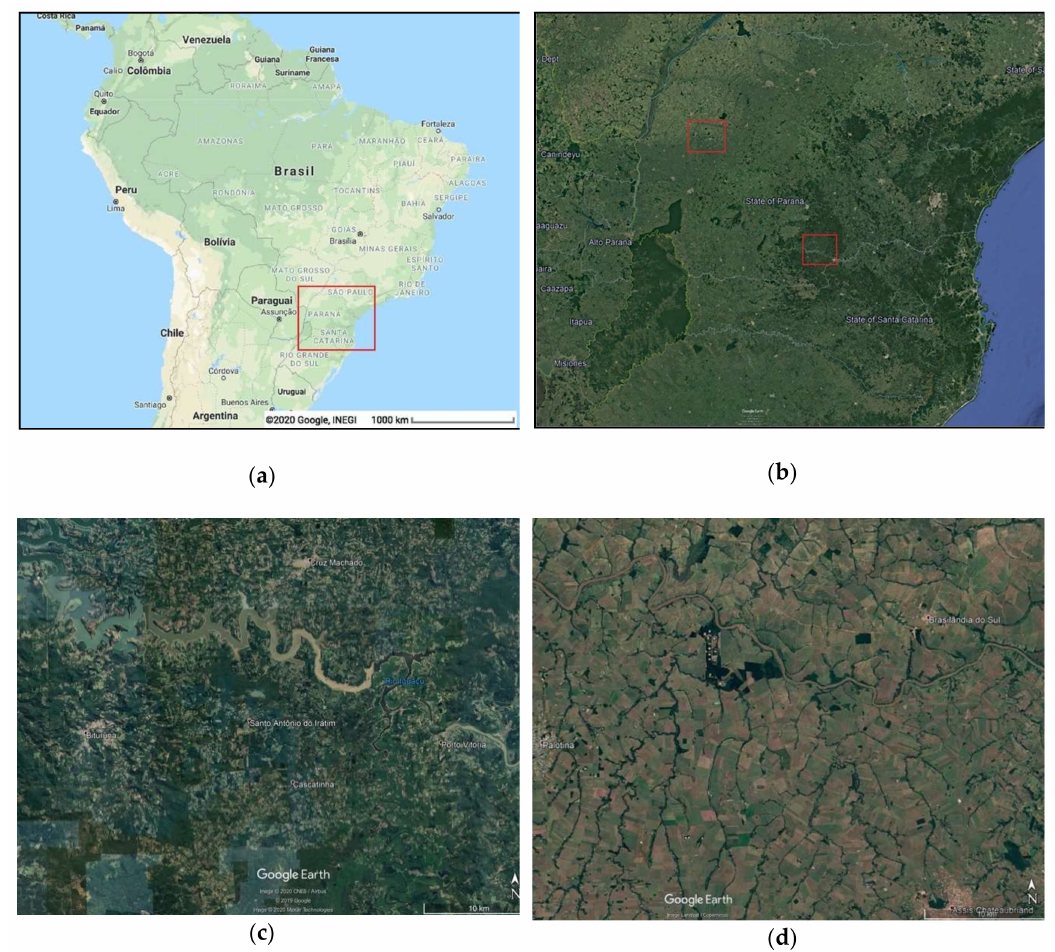
Figure 1. Forest and land use and land cover (LULC) in Paran á state as a result of di ff ering land use legacies: ( a ) location of the region in Brazil; ( b ) Paran á state with northern and southern regions highlighted; ( c ) land use in southern region with a significant incidence of forest cover; ( d ) land use in northern region mostly covered by soy